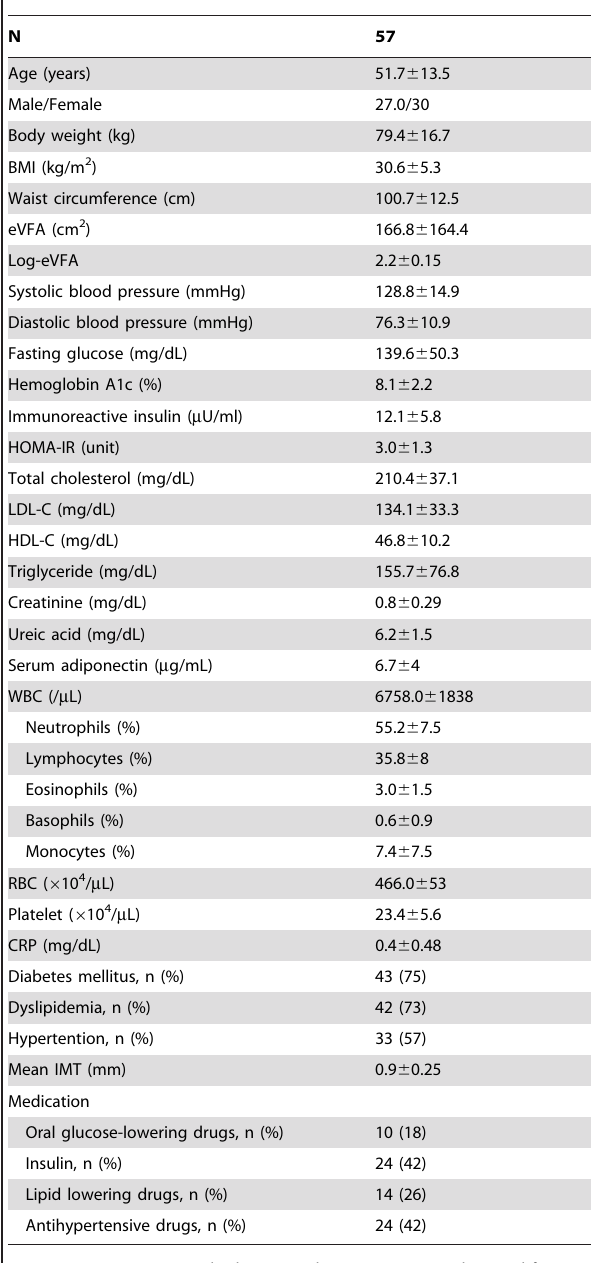
Table 1. Characteristics of participants.